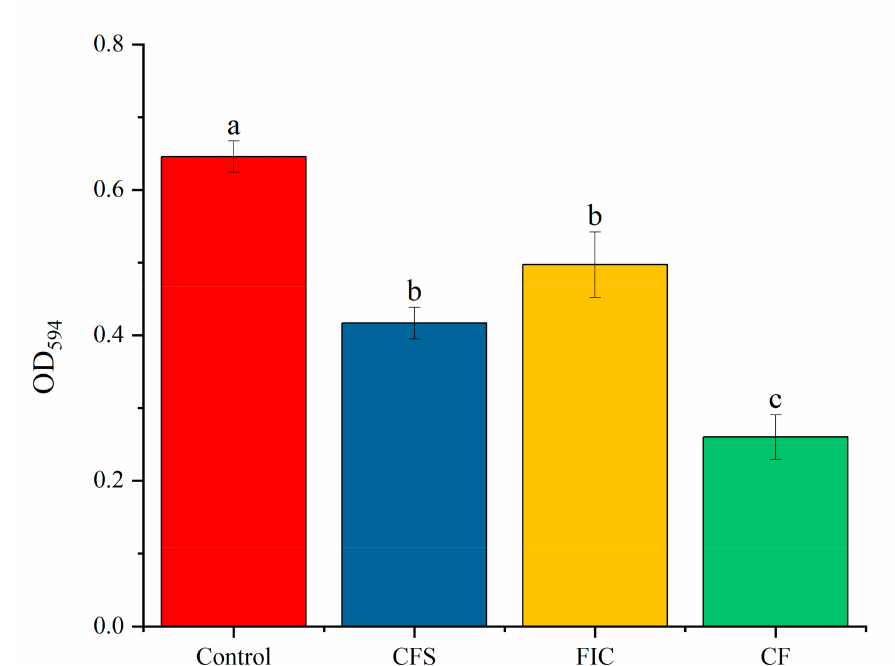
Figure 6. Biofilm biomass of thee H. pylori 3192 biofilm under different treatments. CFS: 1/2 × MIC of LN12 CFS treatment, FIC: 1 × FIC of AMX and CLR treatment, CF: 1/2 × MIC of LN12 CFS in combination with 1 × FIC of AMX and CLR treatment. The experimental data are represented by the mean ± standard deviation ( n = 3), and the groups marked with different superscript letters indicate statistically significant differences ( p < 0.05). AMX: Amoxicillin, CLR: